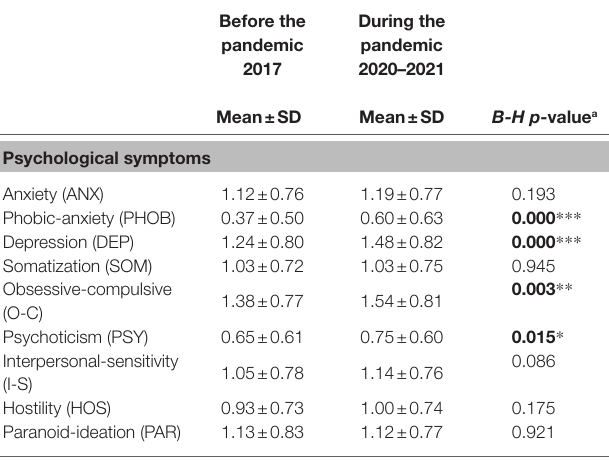
TABLE 1 | Descriptive statistics for psychological health conditions among university students before the pandemic ( n = 545) and during the pandemic ( n =